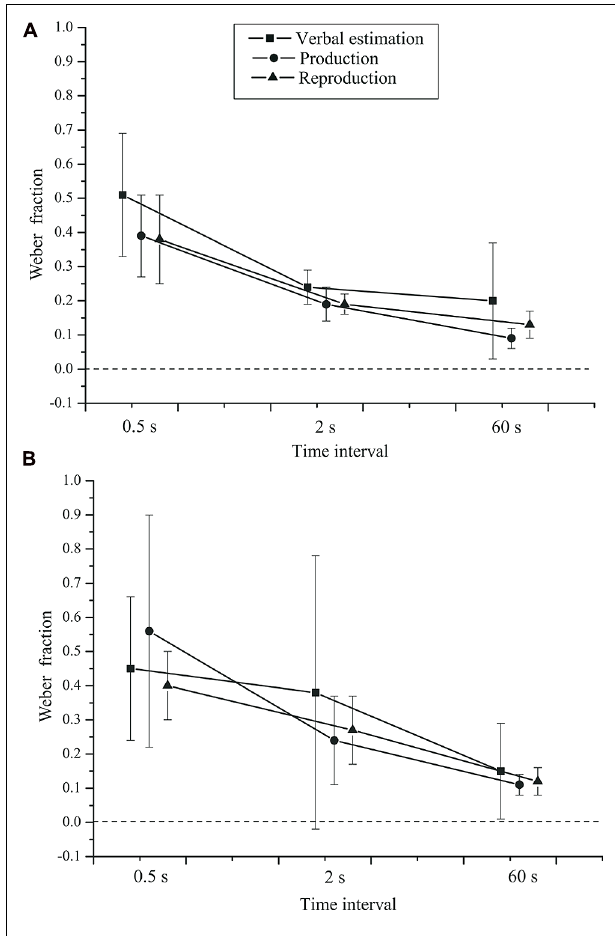
FIGURE 4 | MeanWeber fractions as a function of time interval, task, and group. (A) Control group. (B) Depressive patients. Error bars: 95% CIs.